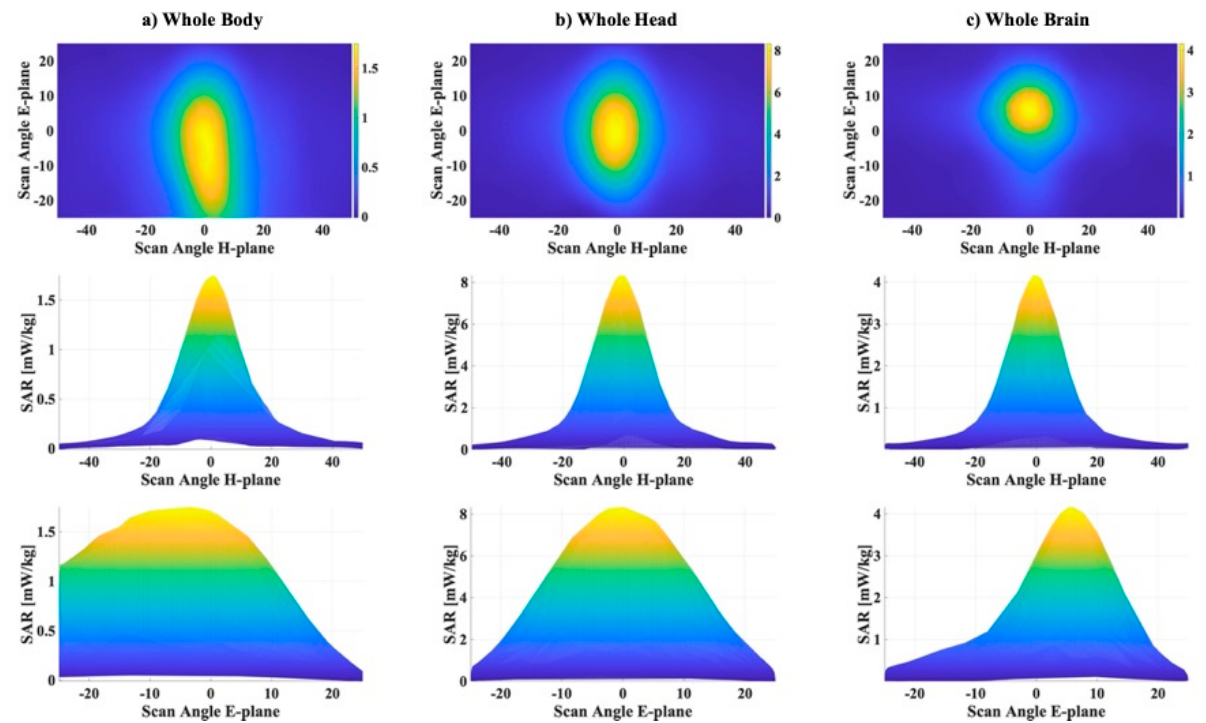
Figure 5. Averaged SAR levels for 1000 combinations of azimuth and elevation angles for ( a ) the whole body, ( b ) the whole head, and ( c ) the whole brain tissue. The first row shows the maps as function of the azimuth and elevation angles; the second row shows the graphs, extracted from the maps, fixed the elevation angle to 0°; the third row shows the graphs, extracted from the maps, fixed the azimuth angle to 0°.